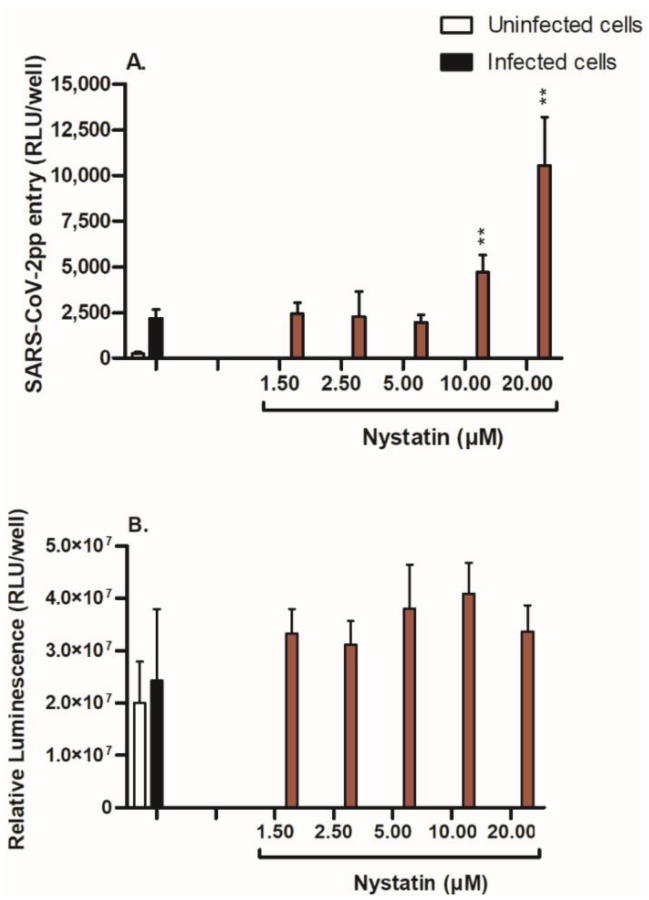
Figure 5. Effect of nystatin on SARS-CoV-2pp entry into Huh7 cells. Huh7 cells were treated with increasing concentrations of nystatin (1.5–20 µ M) prior to SARS-CoV-2pp infection. At 48 h p.i., cells were used for a luciferase assay to measure SARS-CoV-2pp entry into cells ( A ), and for a cell viability assay as assessed by cellular ATP levels ( B ). Values are plotted as the mean ± SD (N = 4). p values were calculated using a two-tailed Student t -test. * p < 0.05 and ** p < 0.001 vs. infected group